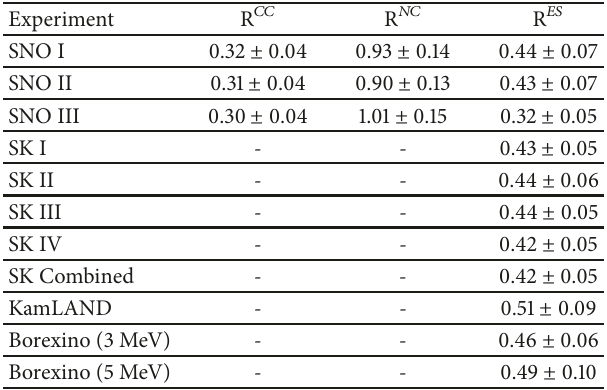
Table 3: Different rates with errors for the SNO, SK, KamLAND, and Borexino